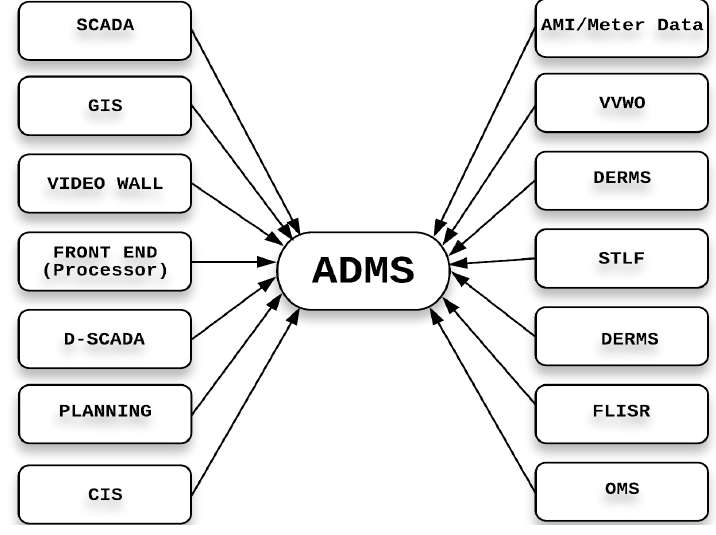
Figure 13. ADMS architecture and its typical